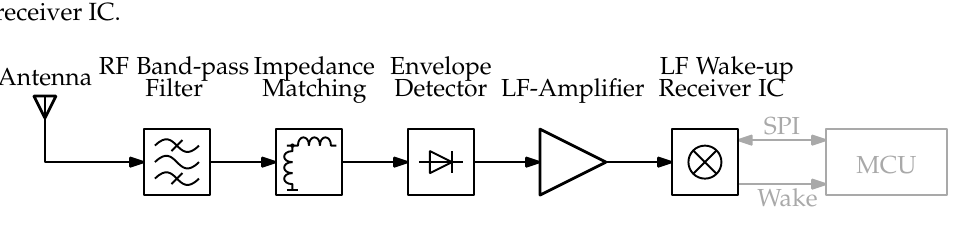
Figure 3. Block diagram of the WuRx